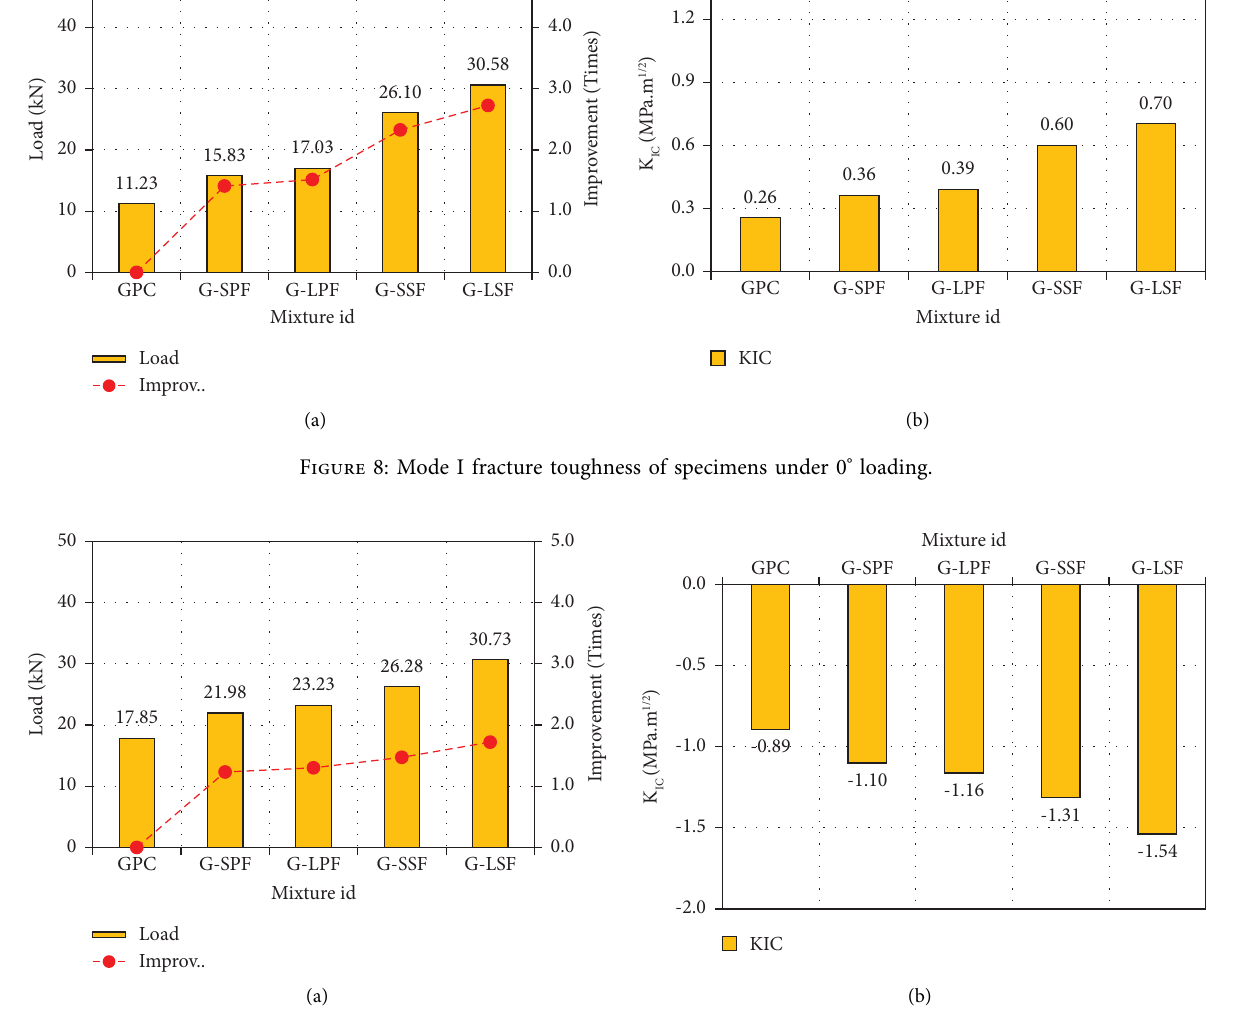
Figure 9: Mode I fracture toughness of specimens under 90 ° loading.